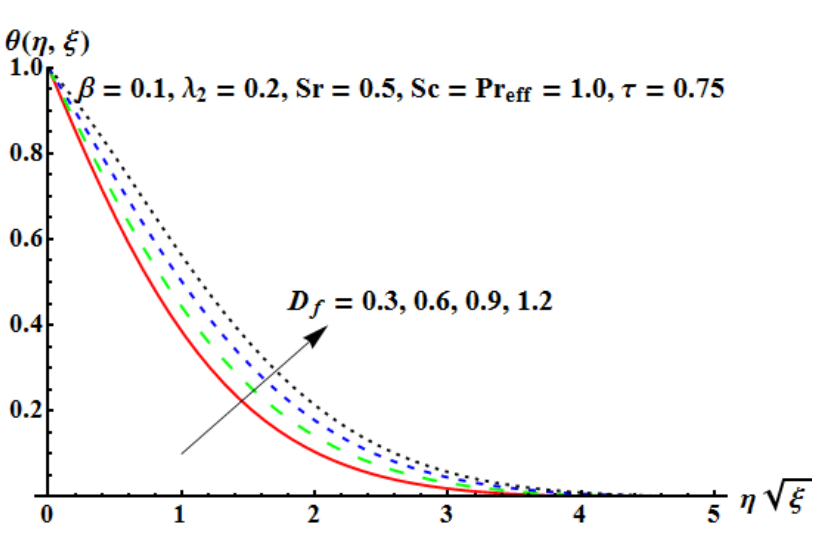
Figure 10. Influence of D f on θ ( η , ξ )